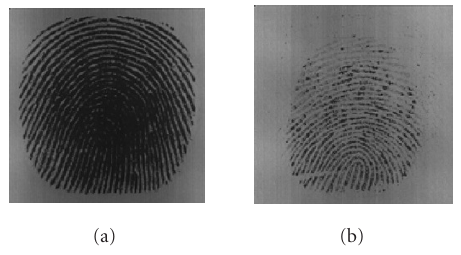
Figure 9: Examples of fingerprint: (a) too wet and (b) too dry.